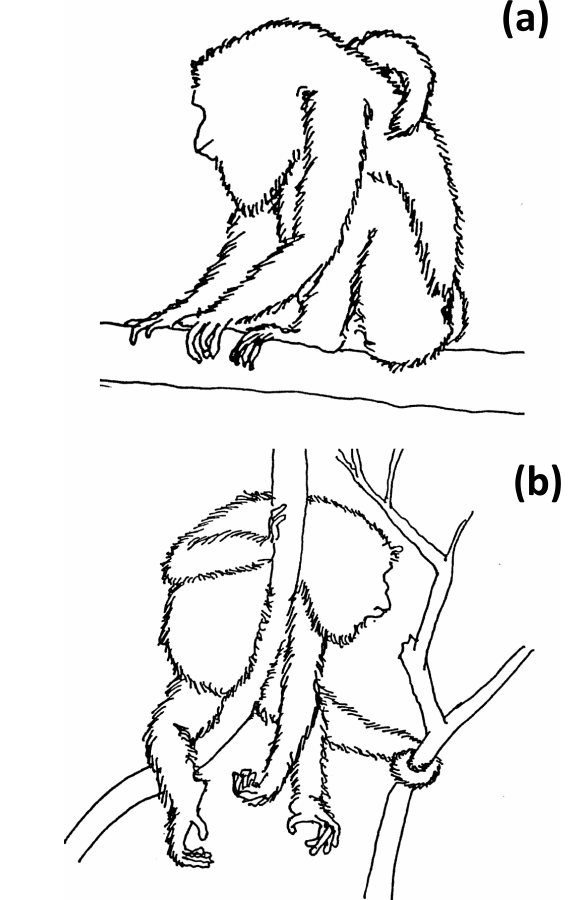
Figure 2. Two sleeping postural modes in Alouatta : (a) sit-in and (b)